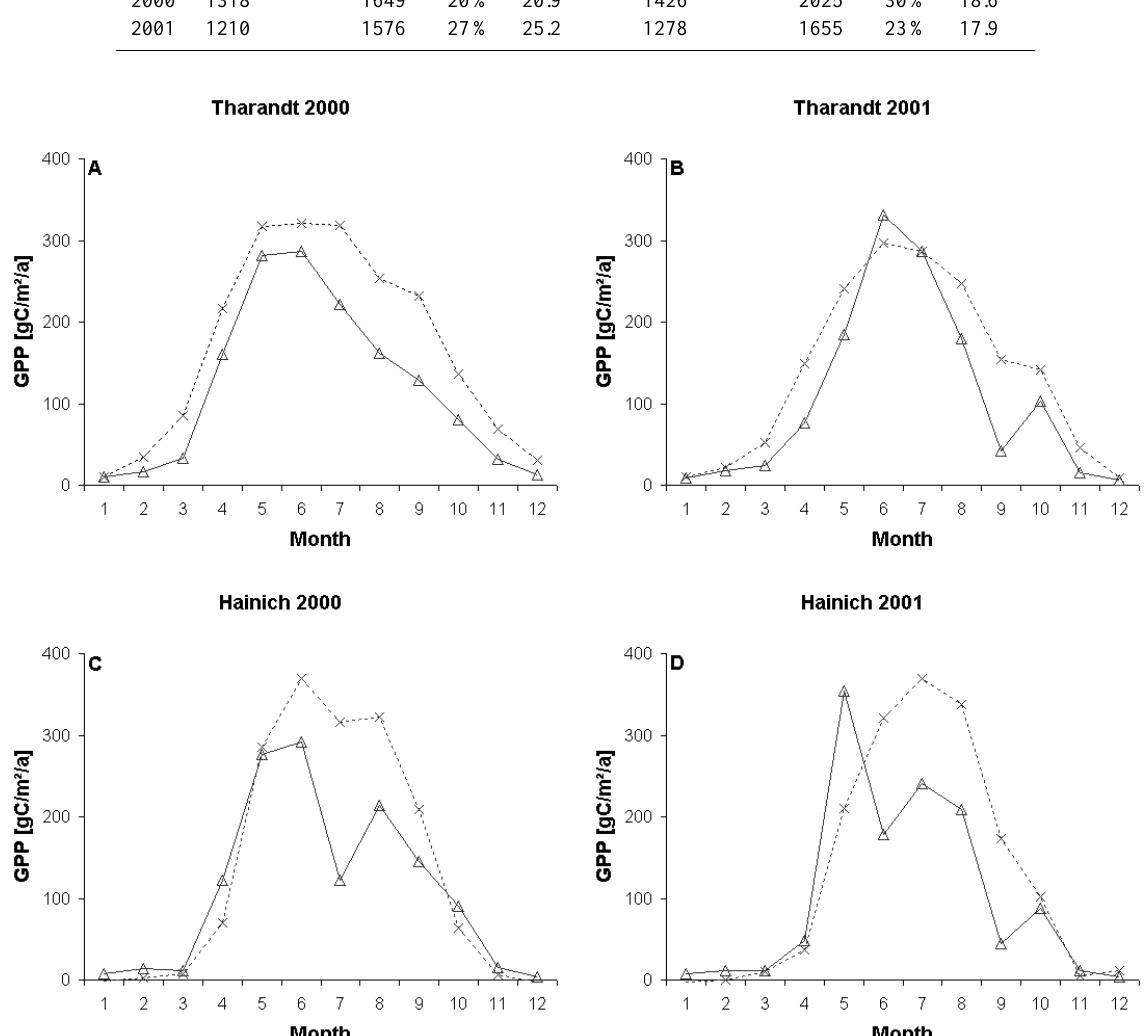
Fig. 2. Monthly GPP sums modelled with BETHY/DLR (solid lines) and measured with eddy flux towers (dashed lines) for the Tharandt and Hainich stations for 2000 and